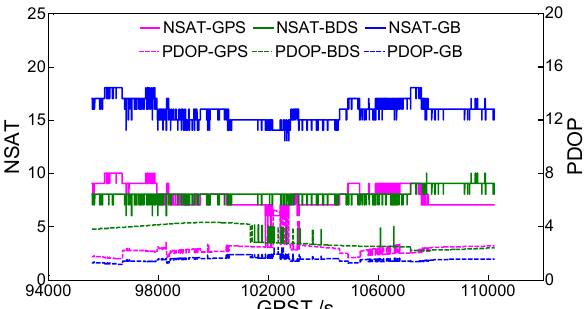
Figure 1. Experimental scene of the static data.